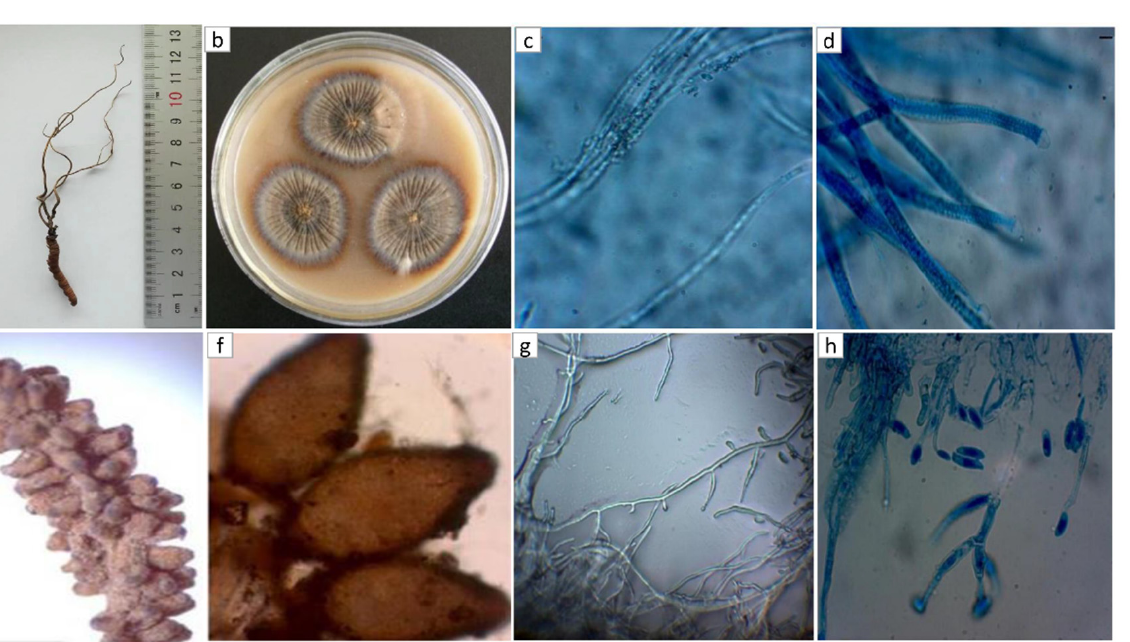
Figure 1. Morphological characteristics of O. lanpingensis : the fresh specimen ( a ), colonies ( b ), asci- and ascospores ( c , d ), fertile part and perithecia ( e , f ), and mycelia and conidia of O. lanpingensis ( g , h ).